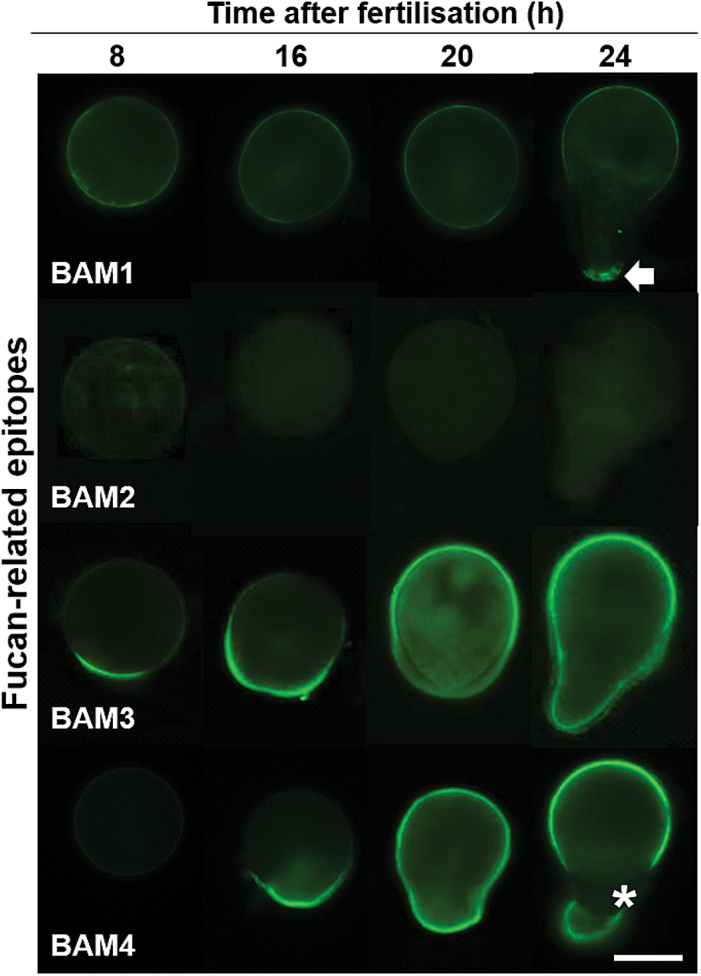
Indirect immunofluorescence labeling of fucan deposition in developing Fucus serratus zygotes. The zygotes/embryos were labeled at the indicated time points following fertilization. The green fluorescence shows the detection of BAM3 and BAM4 fucan epitopes in equivalent individuals. The arrow shows the presence of BAM1 epitopes at the extreme tip of the elongated rhizoid. The asterisk indicates the collar zone of the embryo. Scale bar=50 µm.